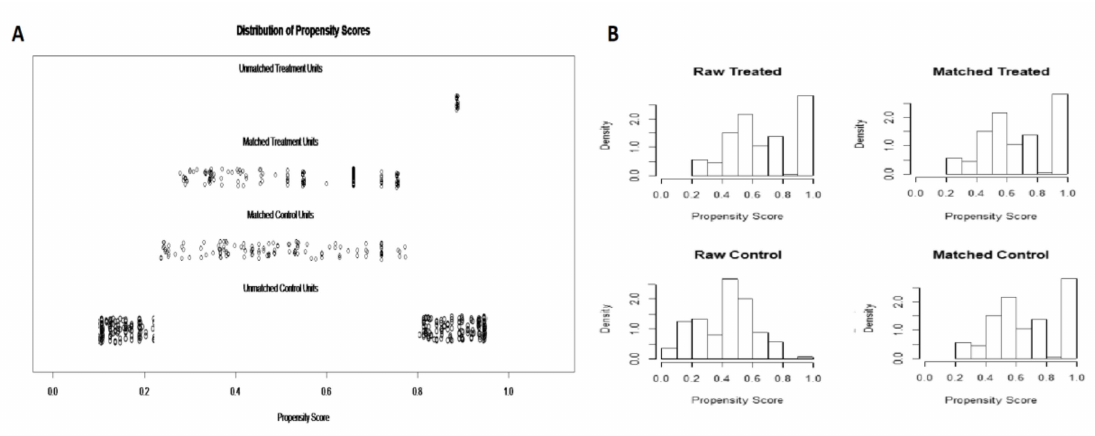
Figure 2. Propensity score matching. Out of the initial 362 patients, after 1-to-1 propensity score caliper matching, 206 patients were selected for comparison: 103 patients who were treated with endoscopic ultrasound contrast-enhanced fine-needle aspiration and 103 patients who were treated with endoscopic ultrasound standard fine-needle aspiration. ( A ) Propensity score matching jitter plot; ( B ) propensity score matching histogram.